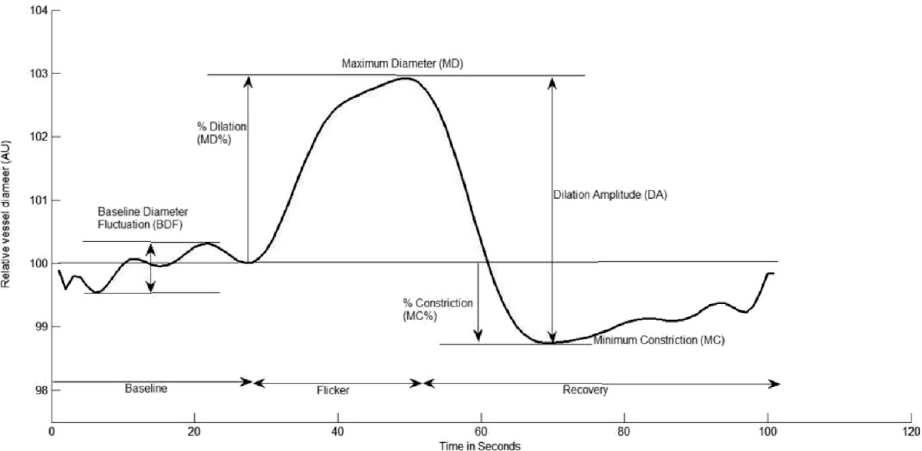
Figure 1. Graphical presentation of the dynamic vessel response profile displaying the parameters calculated and used in analysis. (DA) calculated as (MD-MC). (MD%) calculated as the percent increase from baseline to MD. (MC%) calculated as the percent constriction below baseline following MD. Table 1. General characteristics of the study